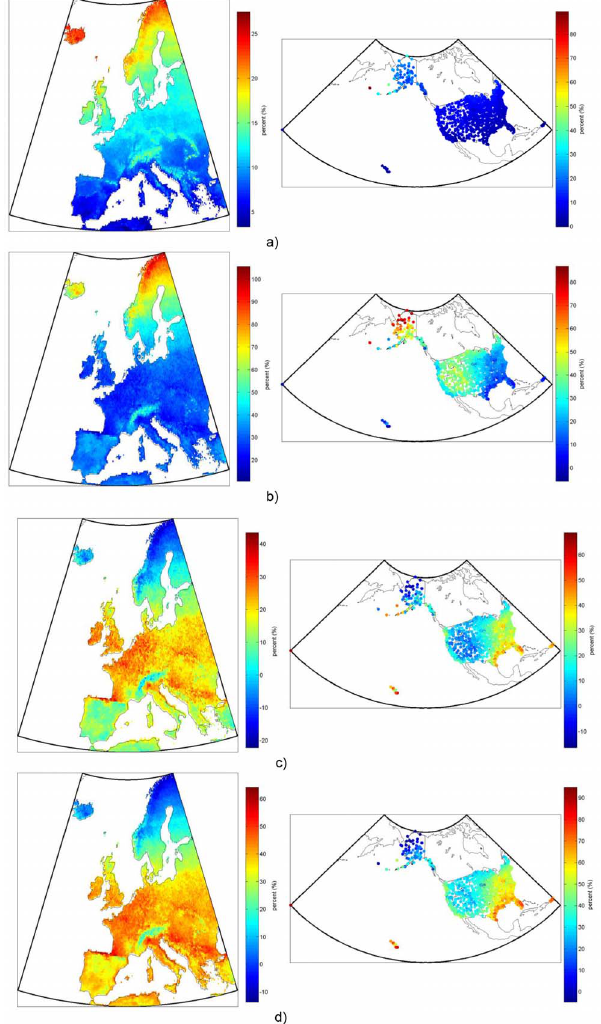
Figure 10. Comparison (in percent) of annual heat production per square meter of installed collector for several representative solar-thermal systems: a) evacuated tube to flat-plate, b) concentrating trough to flat-plate, c) flat-plate to solar trough CHP d) flat-plate to CPV/T. Note that the reference case is always listed last (e.g. ‘‘evacuated tube to flat-plate’’ is the evacuated tube percent increase or decrease from the flat-plate system’s production). Note also that modeled average output temperature from the CPV/T and CHP system is 373K compared to 325K from the thermal-only